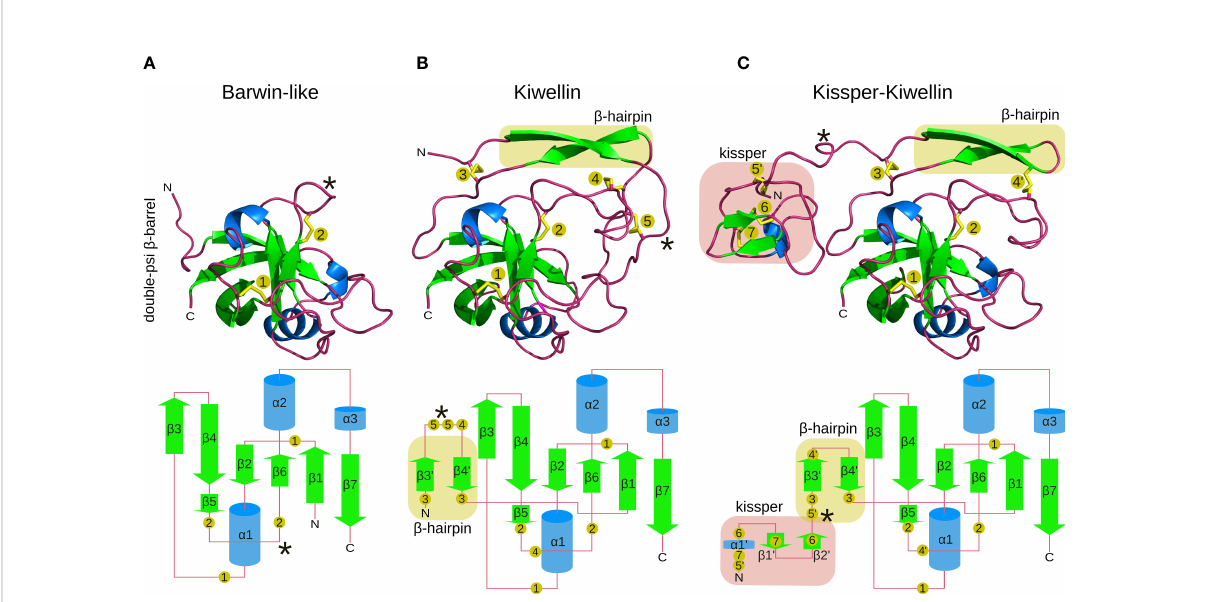
FIGURE 1 Structure-models of Barwin-like (A) , Kiwellin (B) , and Kissper-Kiwellin (C) proteins based on consensus sequences of all proteins identi fi ed for each group (signal peptide removed). Elements visible in the 3D structure on the top are indicated in a planar visualization on the bottom with identical coloring (green: b -sheets, blue: a -helices, red: loop regions). Highlighted in yellow is the b -hairpin and in red is the kissper domain. Numbered, yellow circles indicate the respective disul fi de-boundforming cysteine residues. A loop region with variable length is indicated by